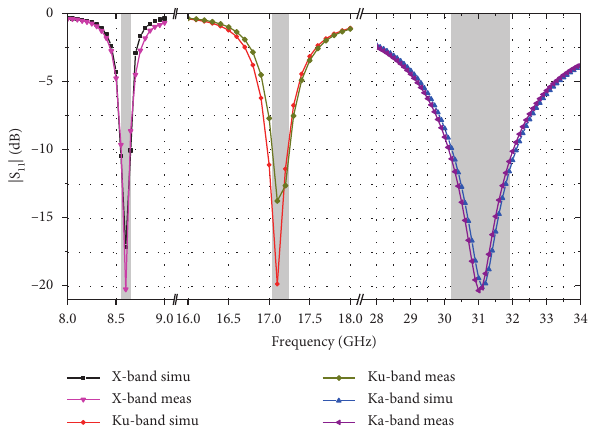
Figure 17: Measured reflection coefficients of FRA prototype working at different states.